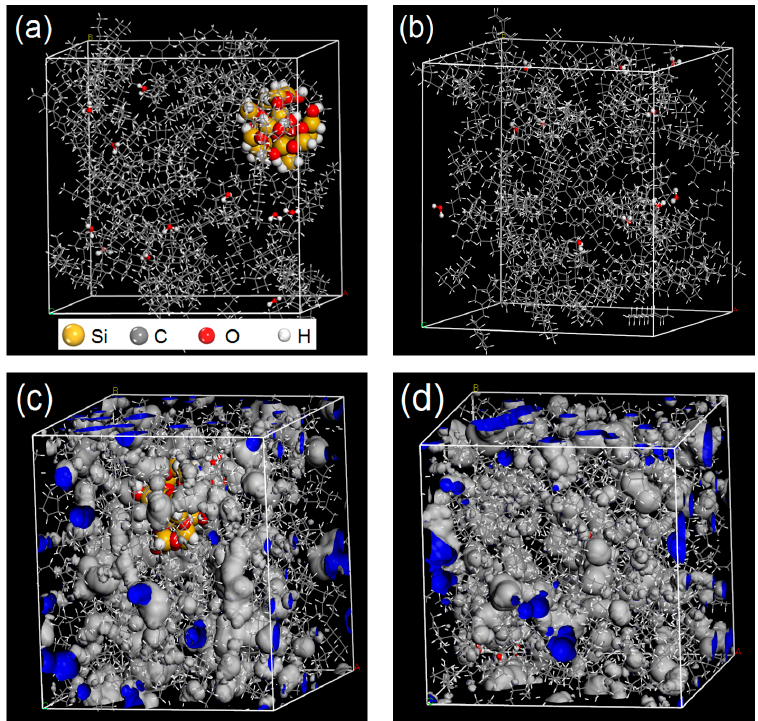
Figure 15. Figure 15. Effect of water on the properties of mineral insulating oil: ( a ) Modified model; ( b ) Unmodified model; ( c ) Statistical results for the Connolly surface of the model in ( a ); ( d ) Statistical results for the Connolly surface of the model in ( b ). results for the Connolly surface of the model in ( b